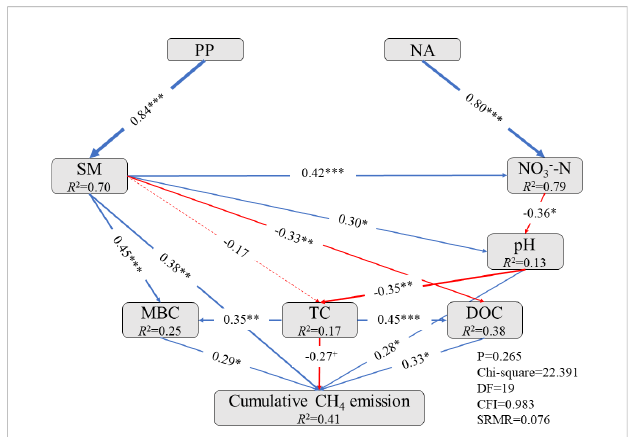
FIGURE 6 Structural equation model (SEM) performed to examine the direct and indirect effects of precipitation pulses and long-term N addition on cumulative CH 4 fl uxes. The blue arrows indicated positive effects, while the red arrows indicated negative effects. The solid arrows indicated signi fi cant paths ( P < 0.05). Conversely, the dotted lines indicated insigni fi cant paths ( P > 0.05). Arrow width represented the strength of the relationship. Values associated with solid arrows represent standardized path coef fi cients. R 2 values represent the proportion of the variance explained for each endogenous variable. Signi fi cance levels are as follows: + , P < 0.1; *, P < 0.05; **, P < 0.01; ***, P < 0.001. Goodness-of- fi t statistics are shown below the model. PP, precipitation pulse; NA, N addition; SM, soil moisture; NO 3 – -N,